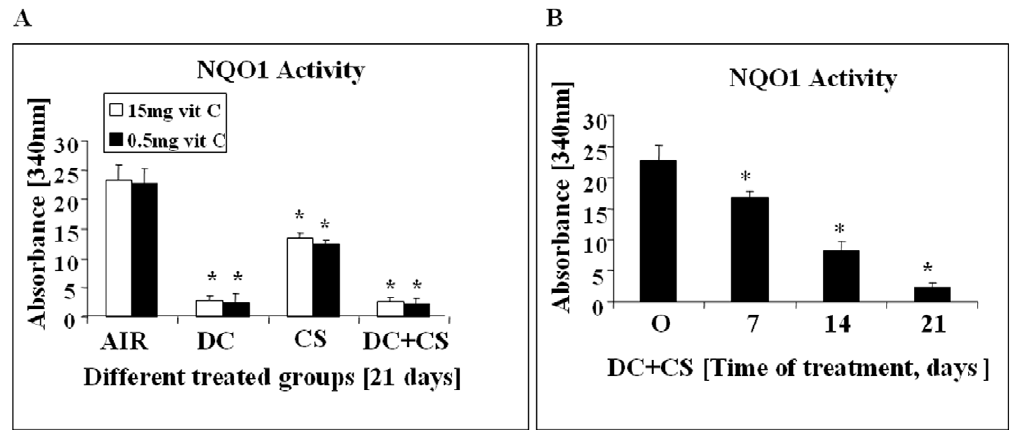
Figure 1. NQO1 Activity of bone marrow cells of guinea pigs fed 0.5 mg or 15 mg vit C/day. (Panel A) AIR, exposed to air; DC, fed 3 mg DC/day; CS, exposed to CS; DC + CS, fed 3 mg DC/day and exposed to CS. * indicates significant difference (p , 0.05) with respect to air exposed guinea pigs.(Panel B) NQO1 activity at different time periods of DC + CS group. * indicates significant difference (p , 0.05) with respect to 0 day. Bars over the respective columns represent means 6 SD (n=6), Vit C means vitamin C.